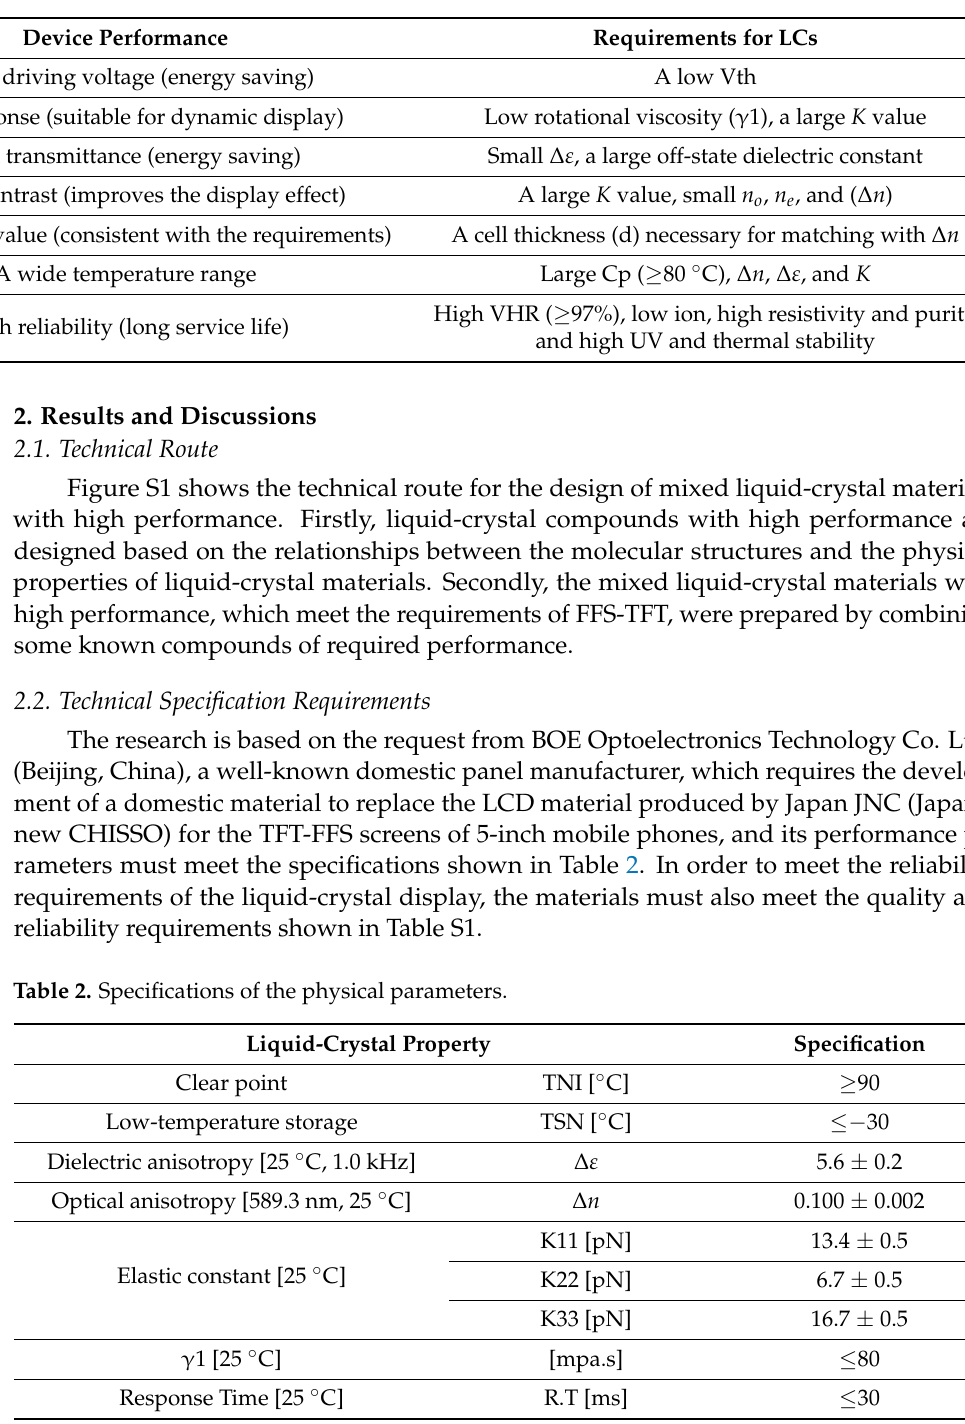
Table 1. Performance requirements of a fringe-field switching-thin-film-transistor liquid-crystal display (FFS TFT-LCD).